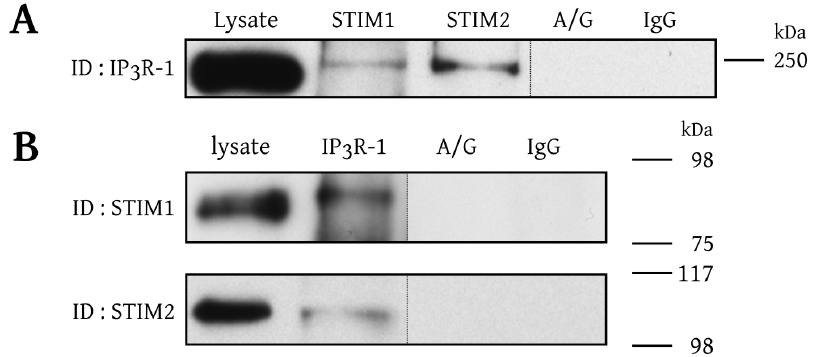
Fig. 3. STIM1 and STIM2 interact with IP 3 R-1. A) BAECs were solubilized in 1% Triton X-100 and the lysate was fractionated into samples that were immunoprecipitated with isoform-specific anti-STIM antibodies or, as control conditions, with IgG antibodies (IgG) or exclusively with protein-A/G agarose beads (A/G). The resulting immune complexes were separated by SDS-PAGE, transferred to PVDF membranes, and immunoblotted with an isoform-specific anti-IP 3 R-1 antibody as indicated on the left side of the blot. B) BAECs lysate was immunoprecipitated with anti-IP 3 R-1 antibody and the blot was revealed with an anti-STIM1 or anti- STIM2 antibodies as indicated. These results are representative of at least three independent experiments performed with different cells preparations. in a nominally free Ca 2 + extracellular medium. Fig. 4A shows the integrated Ca 2 + responses of pre-selected BAECs (average response of 25 cells) transfected with siCtrl (solid black line), siSTIM1 (dashed black line) or siSTIM2 (solid gray line) after stimulation with 100 nM ATP, a submaximal concentration to release Ca 2 + .